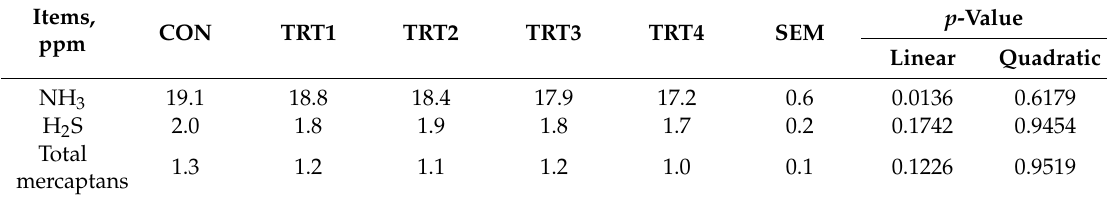
Table 6. E ff ect of coating the blend of OA and MCFA supplementation on excreta gas emission in